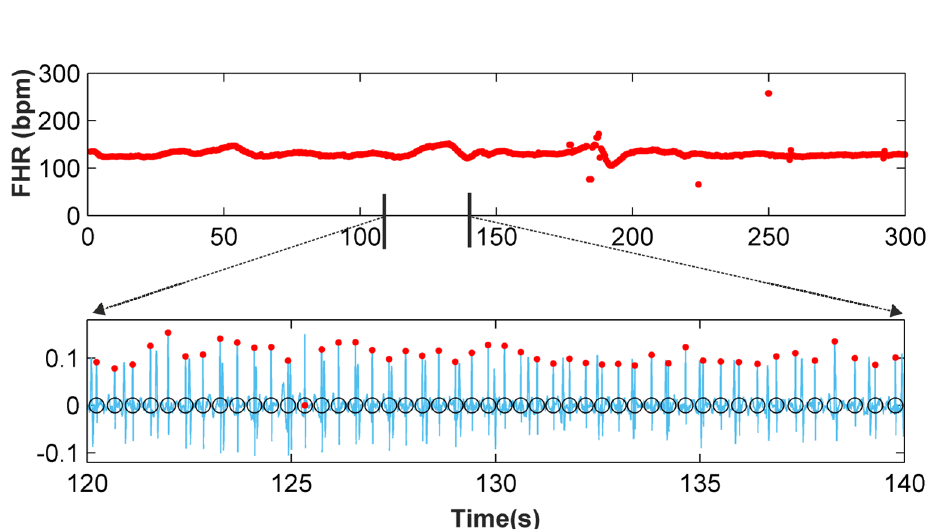
Fig 8. Five-minute FHR monitoring for r08 Ab-4 AECG recording and 20-second fetal QRS complex detection.